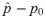
Estimates of p for simulated recent growth.Bias of sex-bias estimators applied to data simulated with recent growth (55x, 205 generations ago) and a constant sex-bias. The true proportion of females, p0, is on the x-axis and the bias of the estimator, p^−p0, is on the y-axis. Our estimator, p˜, models population size change and is unbiased; the estimator pπ, which is based on pairwise sequence diversity π, does not model population size change and is biased for small values of p0.